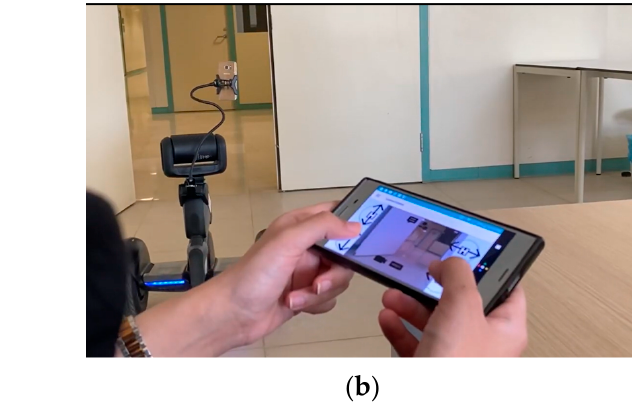
Figure 11. Experimental Setup. ( a ) Pilot user room; ( b ) Controlling the robot to go to the meeting